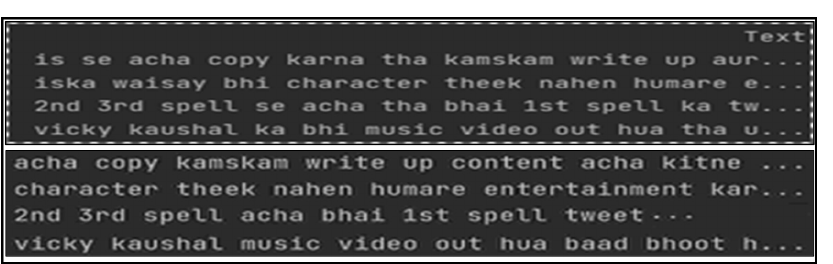
Figure 5. Domain-specific stop word handling in Roman